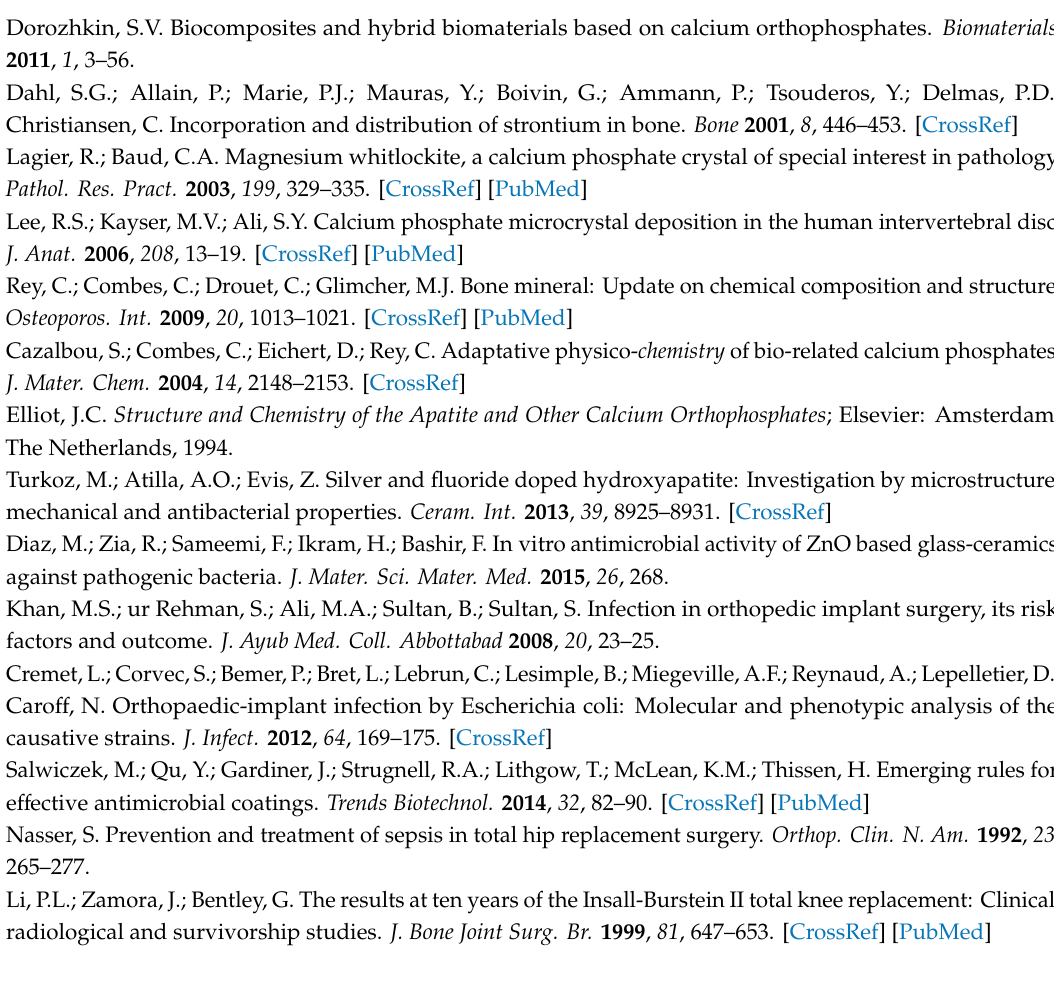
Figure S1: Rietveld plot (conventional Rietveld agreement factors: Rp = 0.048, Rwp = 0.053, χ 2 = 2.26) of the powder pattern of the 25Ag-600 sample with experimental data (red circles), simulated pattern (black line), di ff erence curve (blue line) and Bragg peak position for the six phases present: HAp, Ag ◦ , β -TCP, CDP, CaO and CaCO 3 . Table S1: HAp structural parameters refined by Rietveld analyses on the 27 samples; standard deviations are indicated in brackets. Table S2: TCP lattice parameters refined by Rietveld analyses on the 27 samples; standard deviations are indicated in